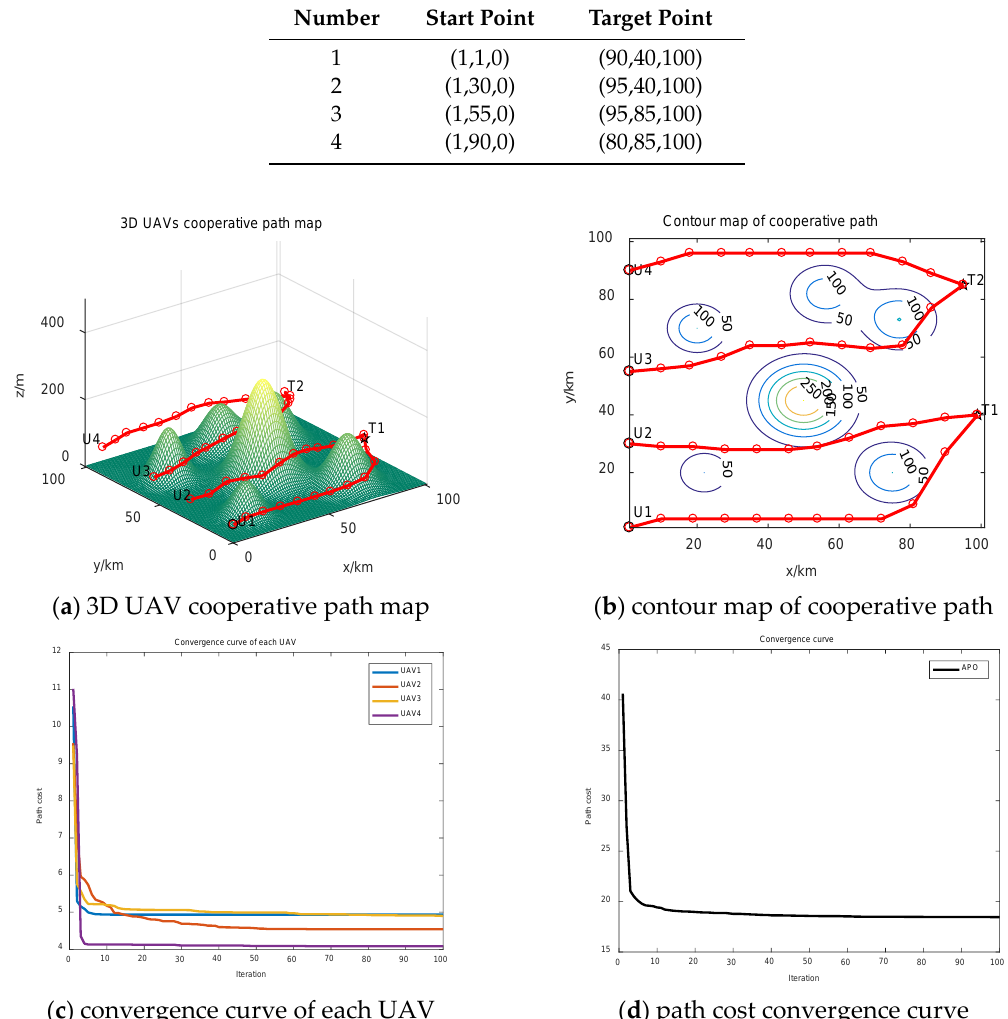
Table 13. Coordinates of the starting and target points of all UAVs (case 3).